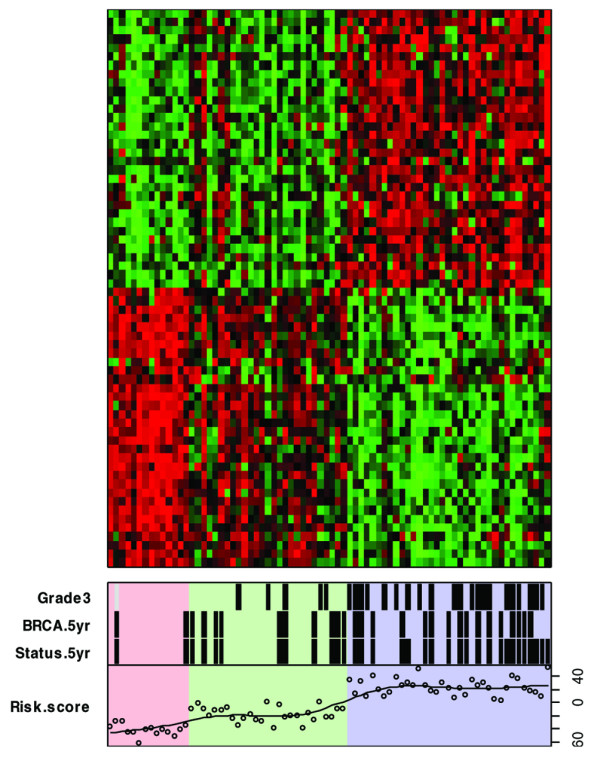
Supervised clustering of the node-positive treated cohort in Uppsala (n = 76) using the 64-gene set. The accompanying variables have the same meaning as in Fig. 2.